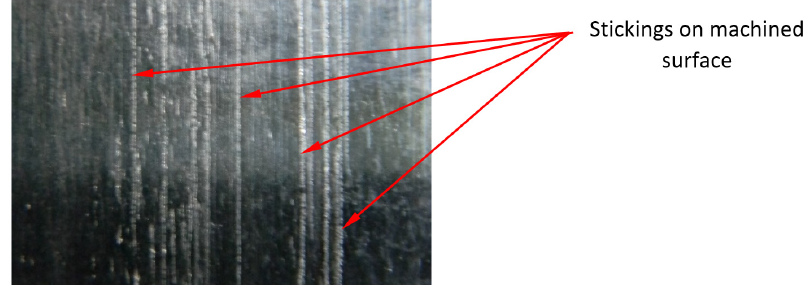
Figure 17. Machined surface after dry machining with conventional insert of Inconel 718, f = 0.05 mm/rev.